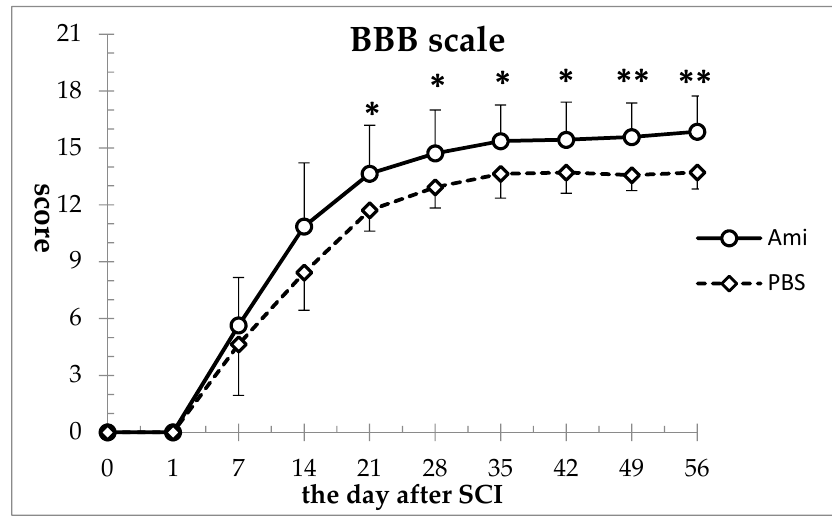
Figure 1. Amiloride improved motor function recovery after spinal cord injury (SCI). Basso, Beattie, Breanahan locomotor rating scale (BBB) scale scores were significantly higher in the amiloride group compared to the phosphate buffered saline (PBS) group from day 21 to day 56. Asterisks indicate significant difference between the amiloride group (Ami) and the PBS group (PBS) with two-way repeated measures analysis of variance (ANOVA), followed by Tukey’s multiple comparison test (* p < 0.05, ** p < 0.01, n = 5 per group, error bars are standard deviations).